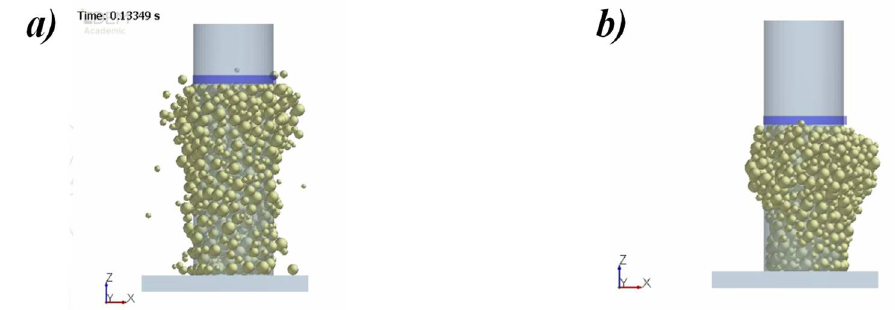
Figure 7. Behavior of powder for: ( a ) Γ < 1 × 10 − 5 J/m 2 and ( b ) Γ > 1 × 10 − 5 J/m 2 . Measured values of the unconfined yield strength (f c ) as function of the coefficient of rolling friction ( µ R, P − P ) provided a fixed value of Γ have been reported in a plot. Fitting these values of f c with a regression line, the couple of the parameters ( µ R, P − P , Γ ) which gives the experimental f c is the desired